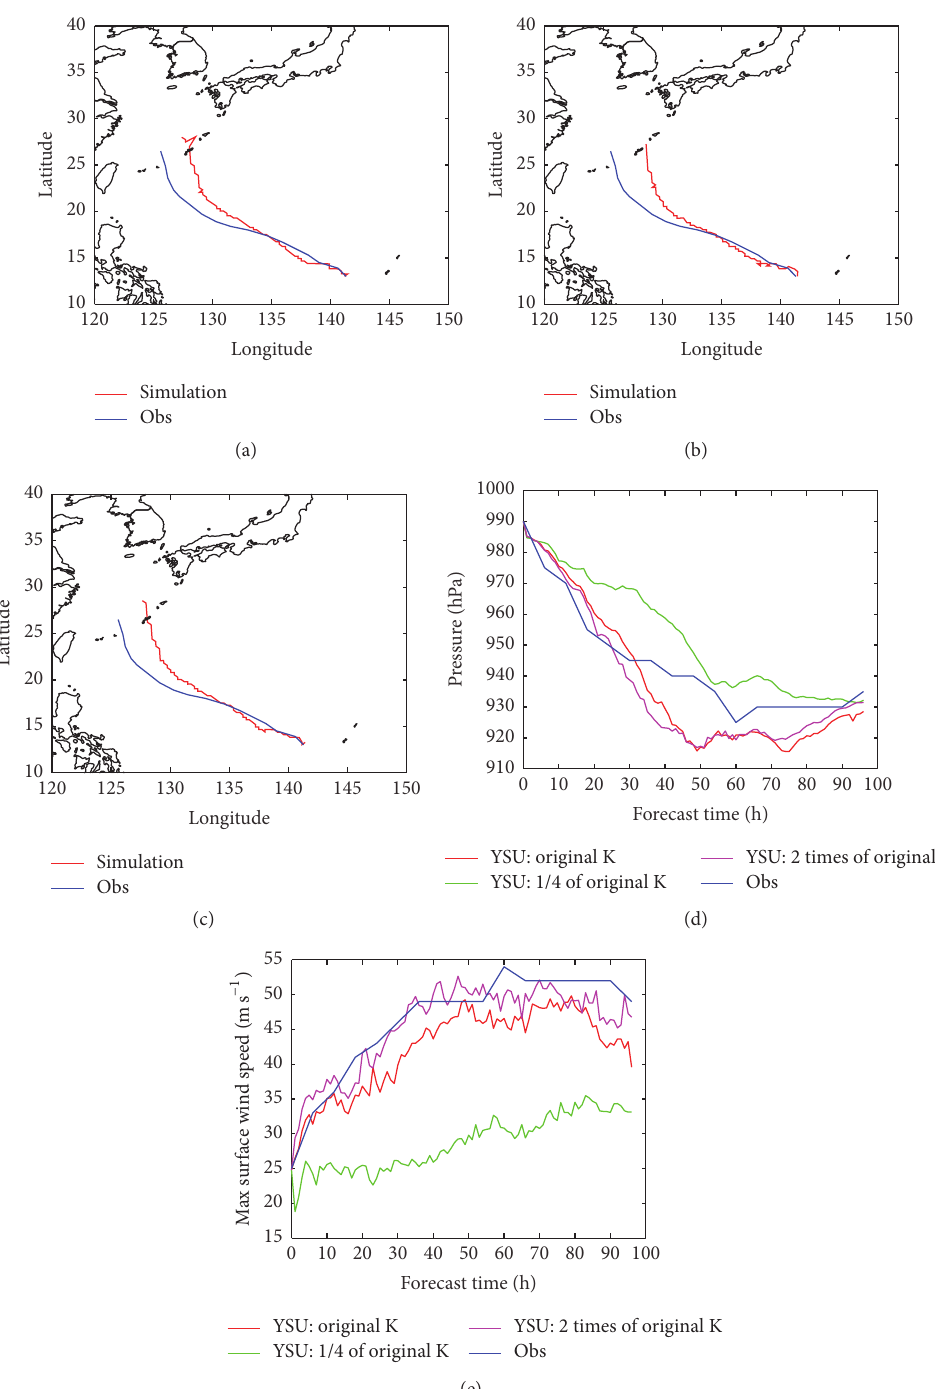
Figure 2: Case 1-Neoguri: (a) track simulated by the original YSU; (b) track simulated by the K025; (c) track simulated by the K200; (d) comparisons of center sea-level pressure; and (e) comparisons of maximum surface wind speed.